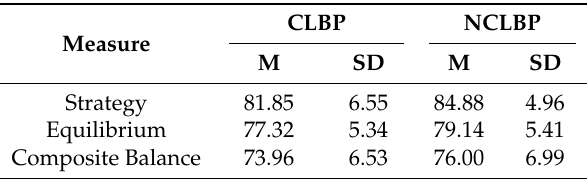
Table 3. Neurocom data